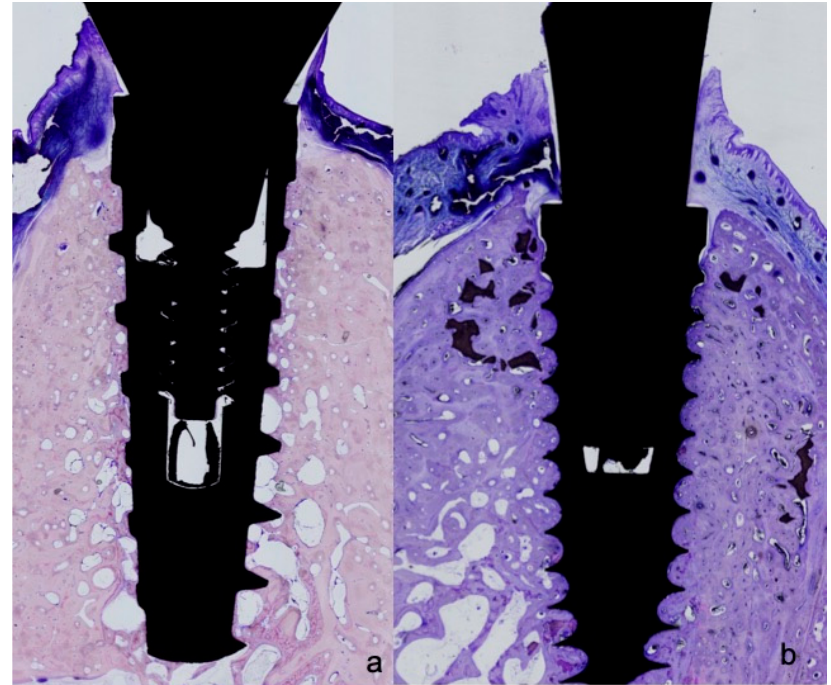
Figure 3. ( a ) Histological preparations representing the outcome after 8 weeks healing showing open-thread neck design of the IPX implant; and, ( b ) after eight weeks healing showing (open-thread) double-spiral neck design of the Facility implant.